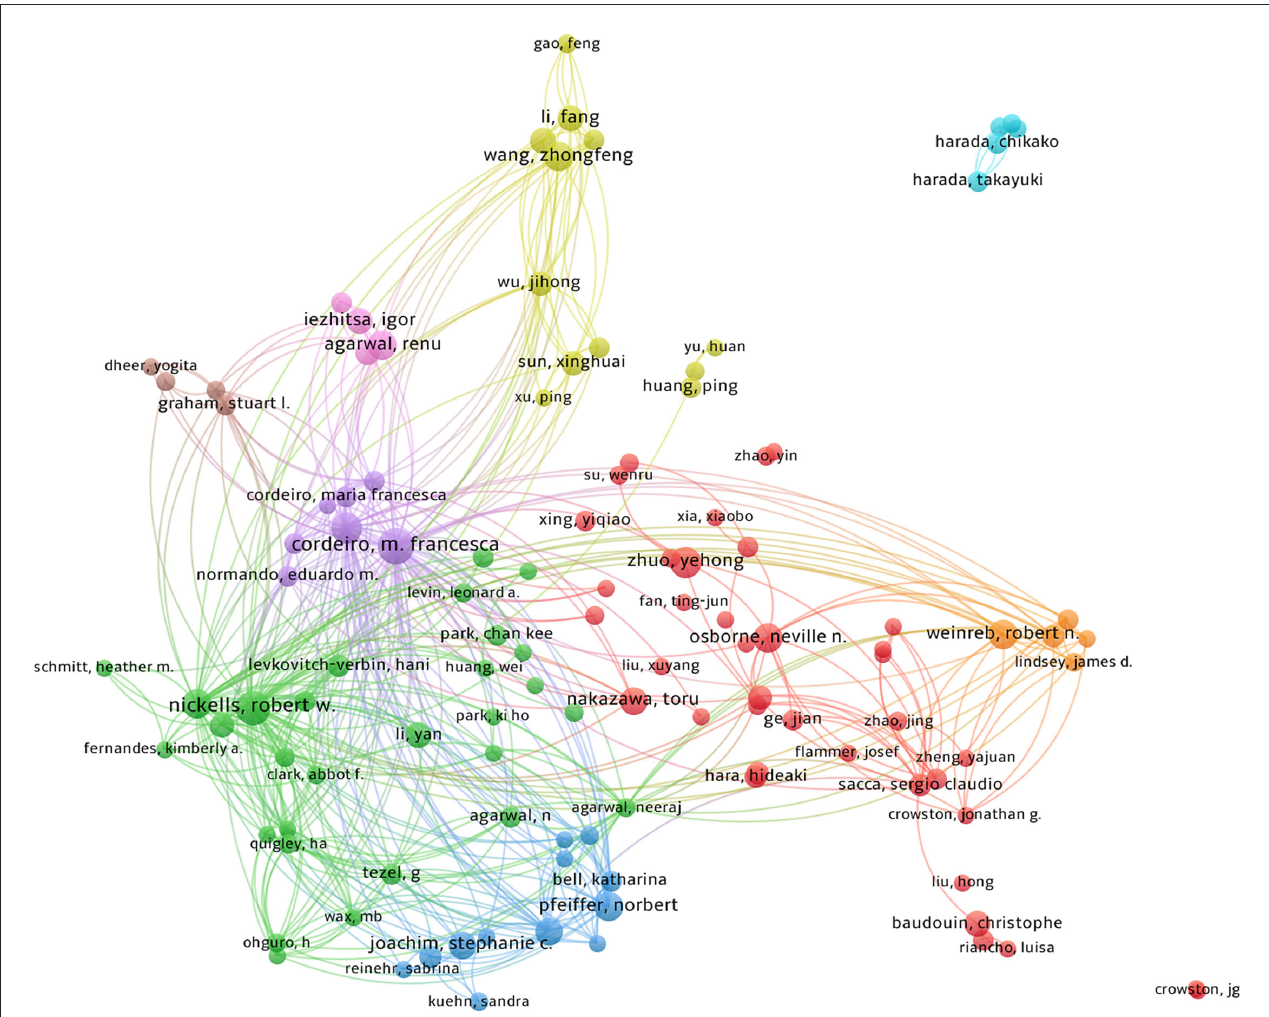
FIGURE5 A total of 6,888 authors participated in the writing process. The Linlog/modular model was used for analysis. The weight is Total Link Strength. The size of the circle represents the amount of influence of the author. Inter-node connections represent author collaboration and the lines of connection between nodes represent the collaboration between